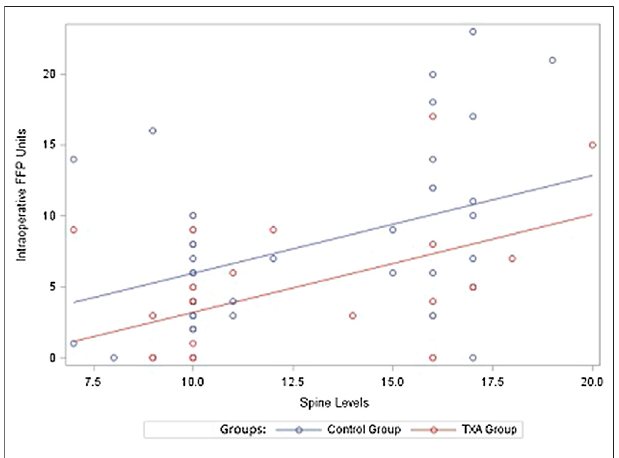
FIGURE 3 | Intraoperative transfused red blood cell units. RBC, red blood cells; TXA, tranexamic acid.